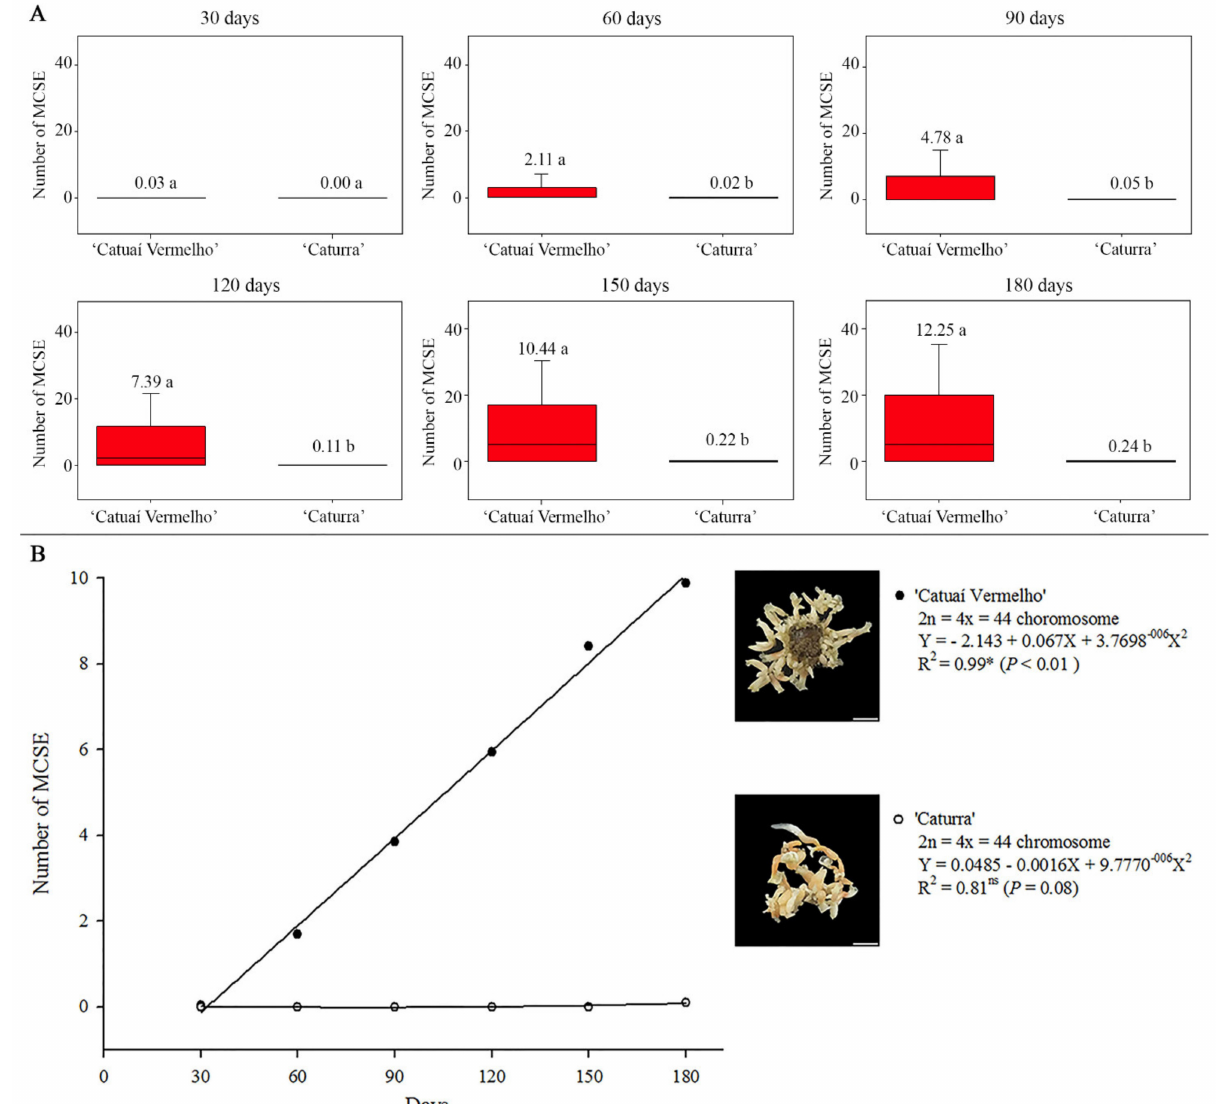
Figure 2. MCSE mean number for ‘Catua í Vermelho’ and ‘Caturra’ in SE regeneration medium for 180 days. ( A ) Box plots show that ‘Catua í Vermelho’ and ‘Caturra’ exhibited distinct MCSE mean numbers. ( B ) The adjusted model was significant ( p < 0.01) by the quadratic polynomial regression for ‘Catua í Vermelho”. The regenerated SE exhibited different stages of globular, cordiform, torpedo and cotyledonary development. Mean values followed by the same letter do not present a significant difference. Bar = 2